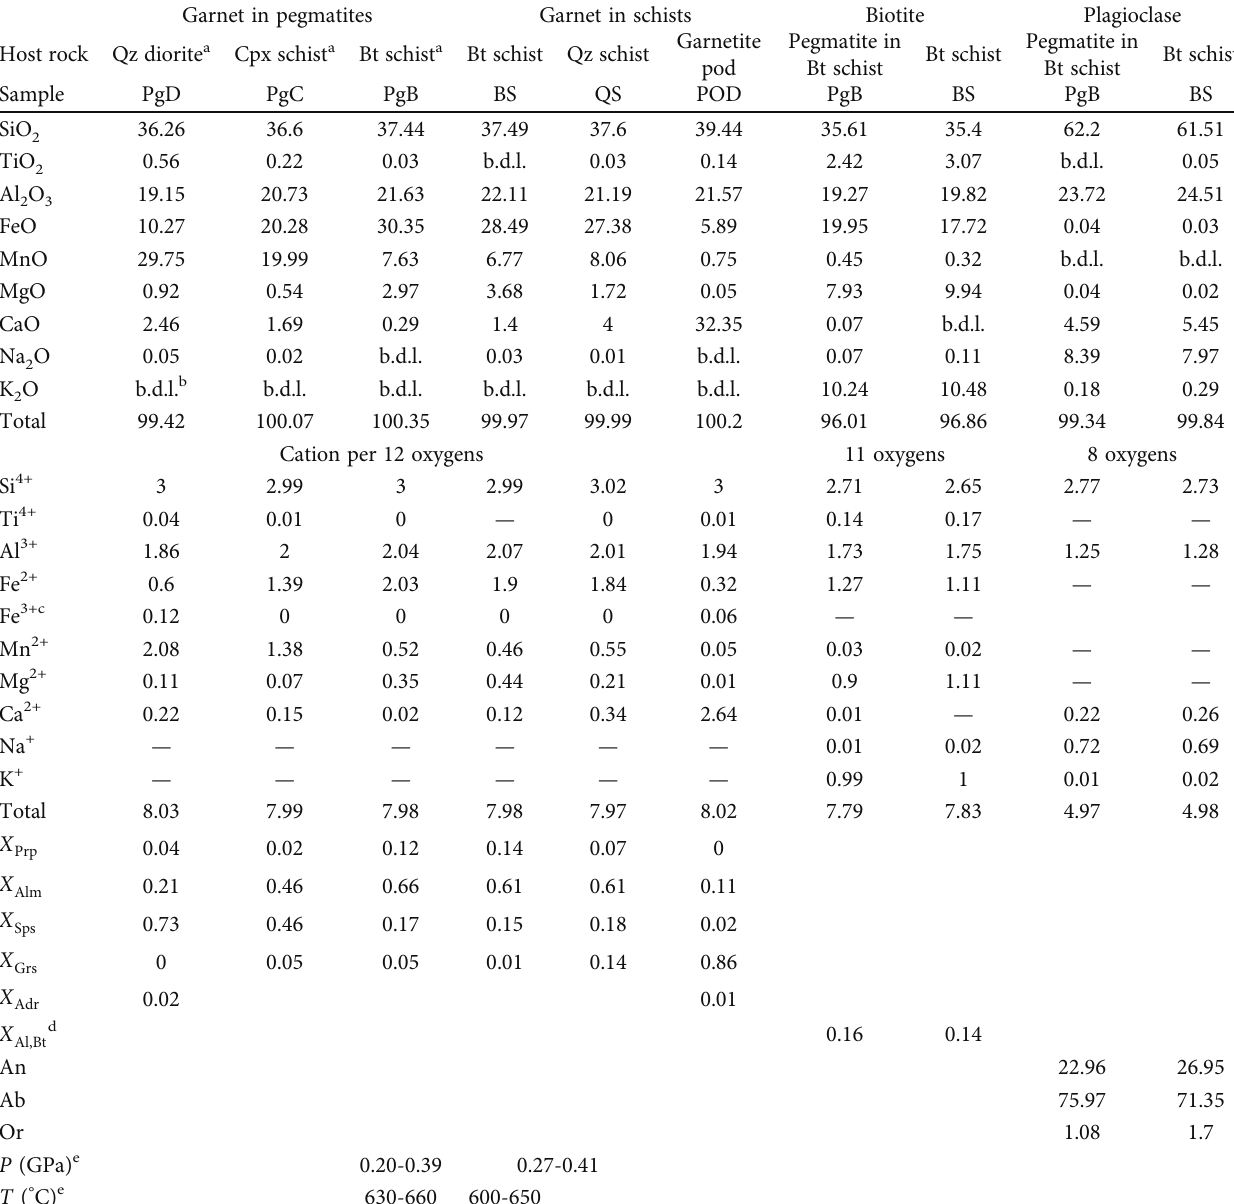
Table 2: The representative composition of garnet, biotite, and plagioclase in Kinkasan Island. Garnet in